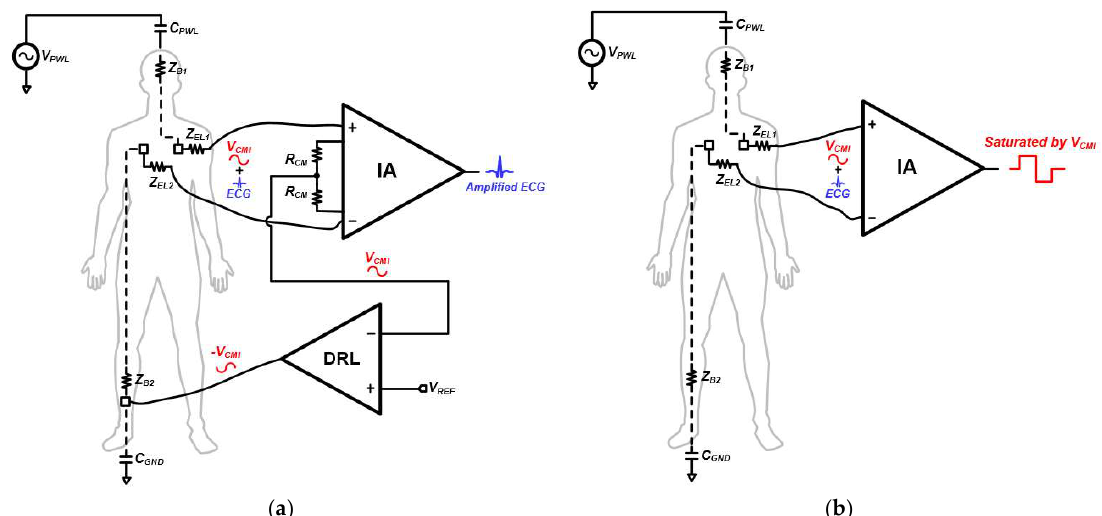
Figure 1. ( a ) Conventional three-electrode ECG monitoring; ( b ) two-electrode ECG monitoring.